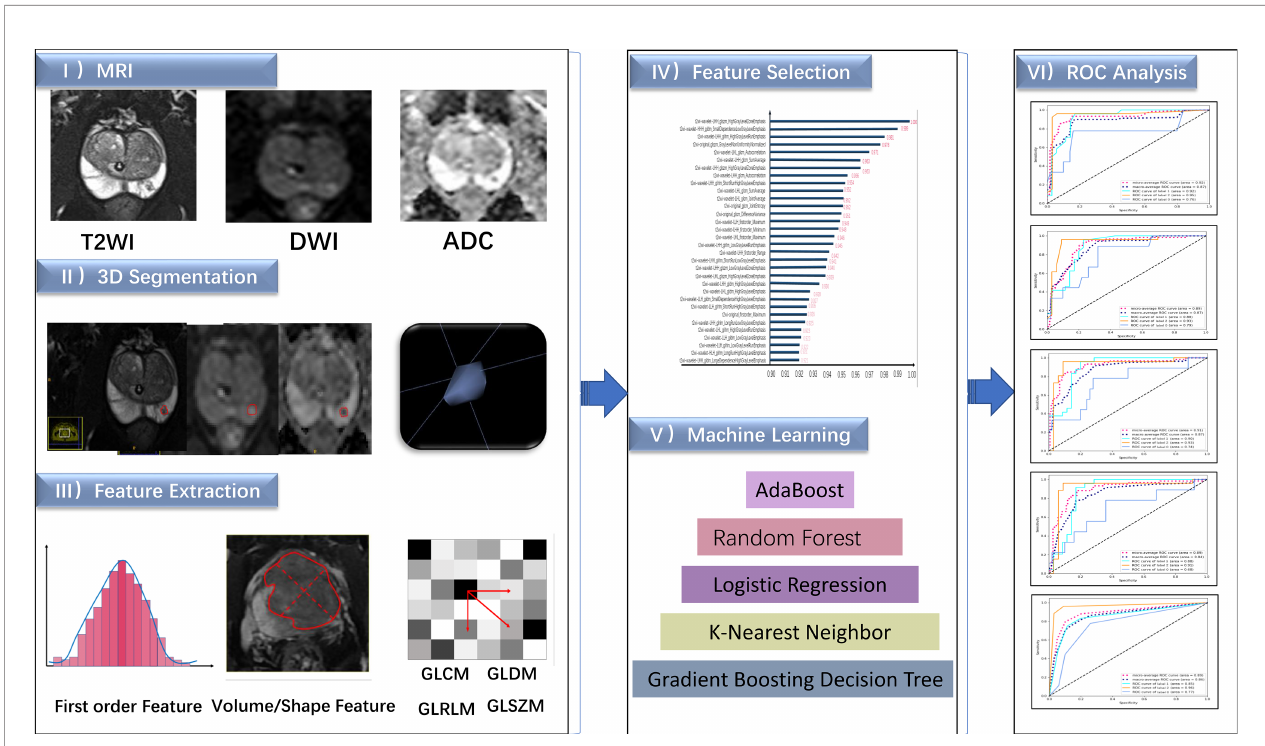
FIGURE 2 | The fl ow chart of this